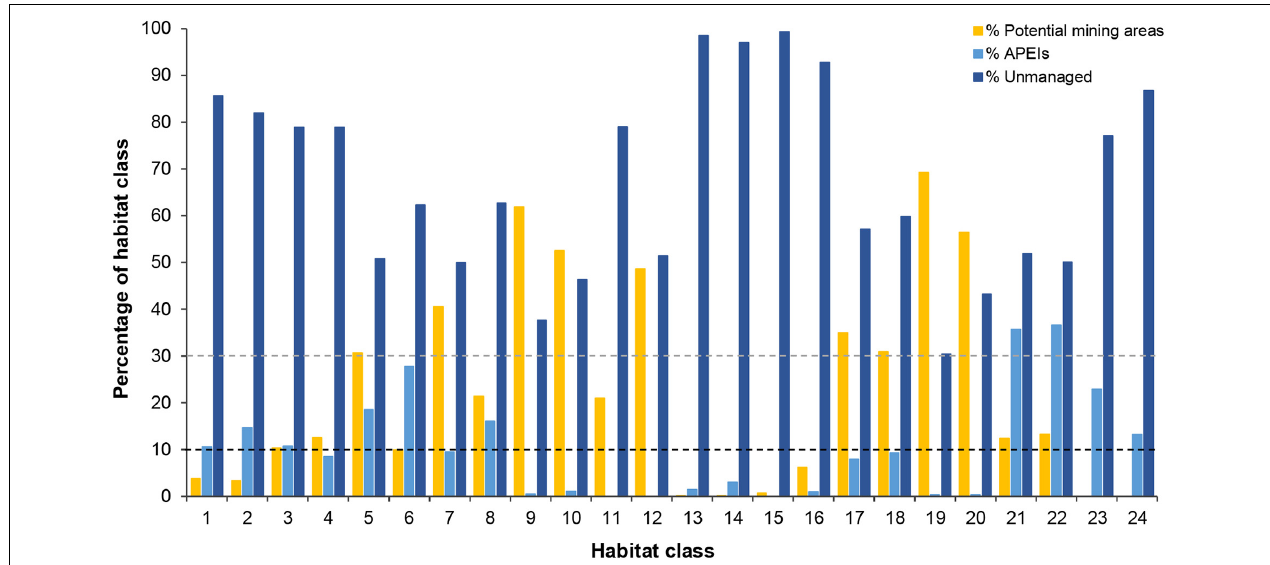
FIGURE 8 | Percentage of the total area of each habitat class occurring in APEls, potential mining areas (exploration contracts and/or reserved areas) and unmanaged areas. Dashed lines represent conservation targets|